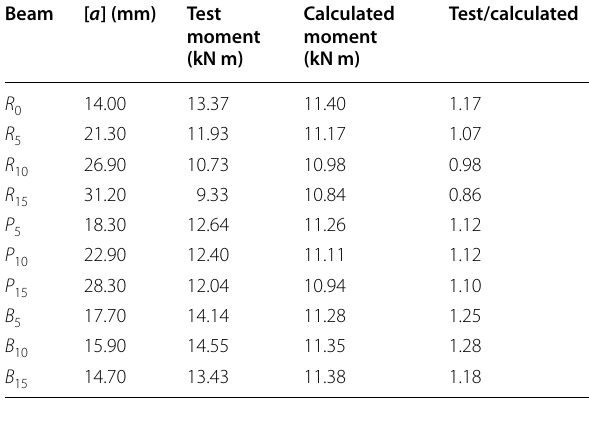
Table 4 Test and calculated moment capacity of the